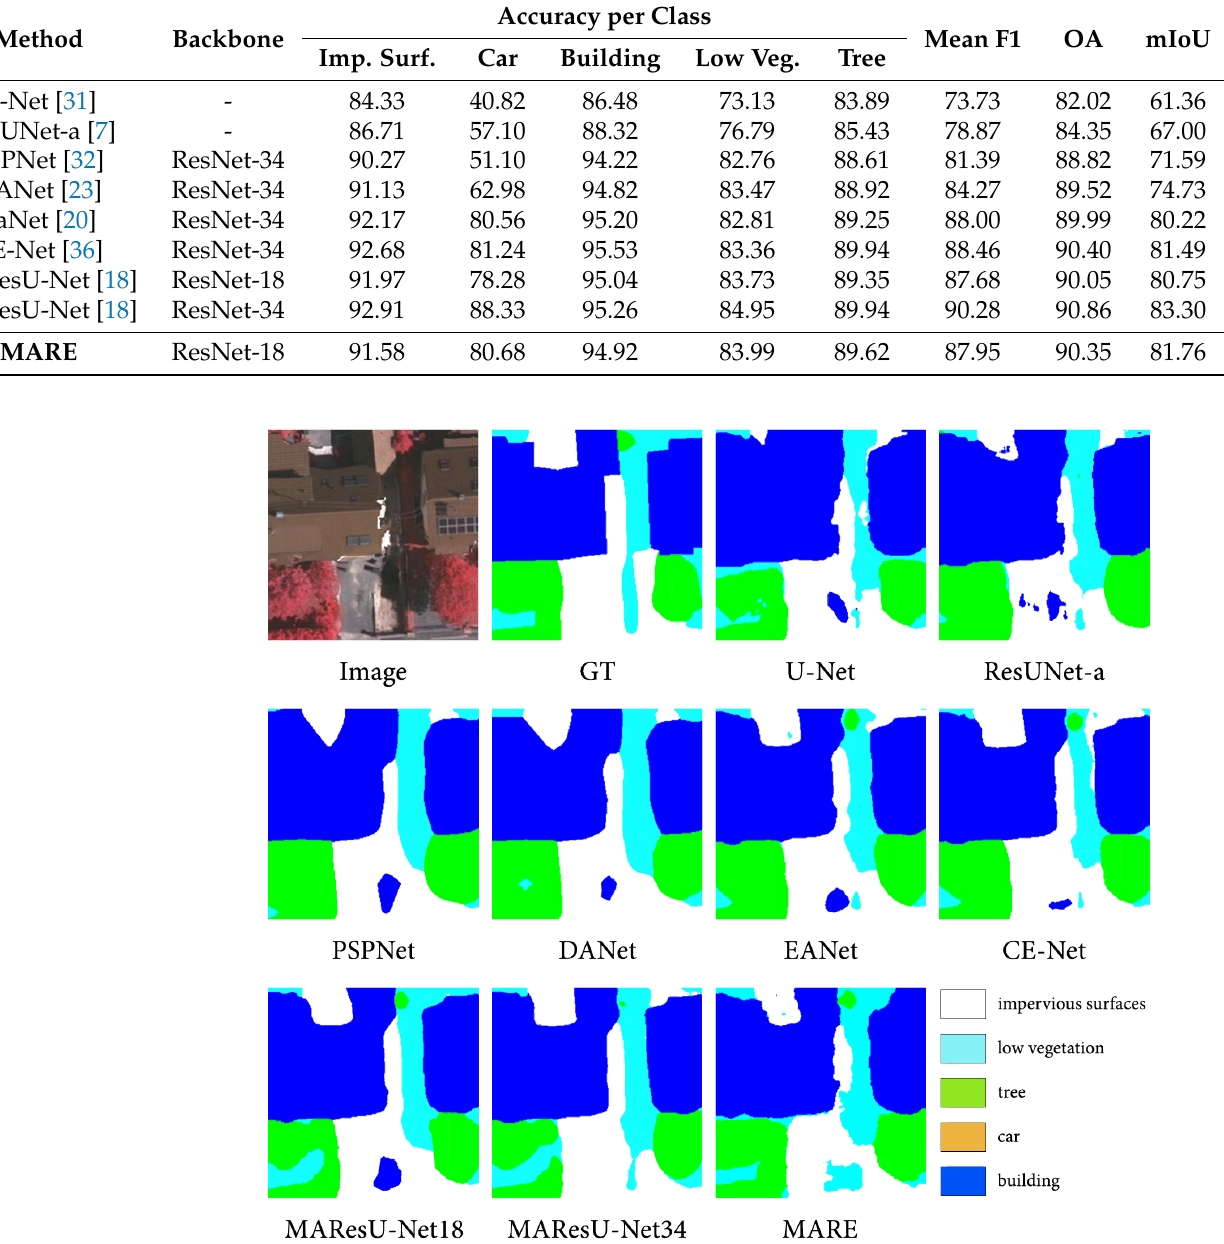
Table 2. Experimental results on Vaihingen dataset [28] w.r.t. the results proposed in [18]. We can observe how MARE reaches the best results with a ResNet-18 encoder in all the adopted metrics.